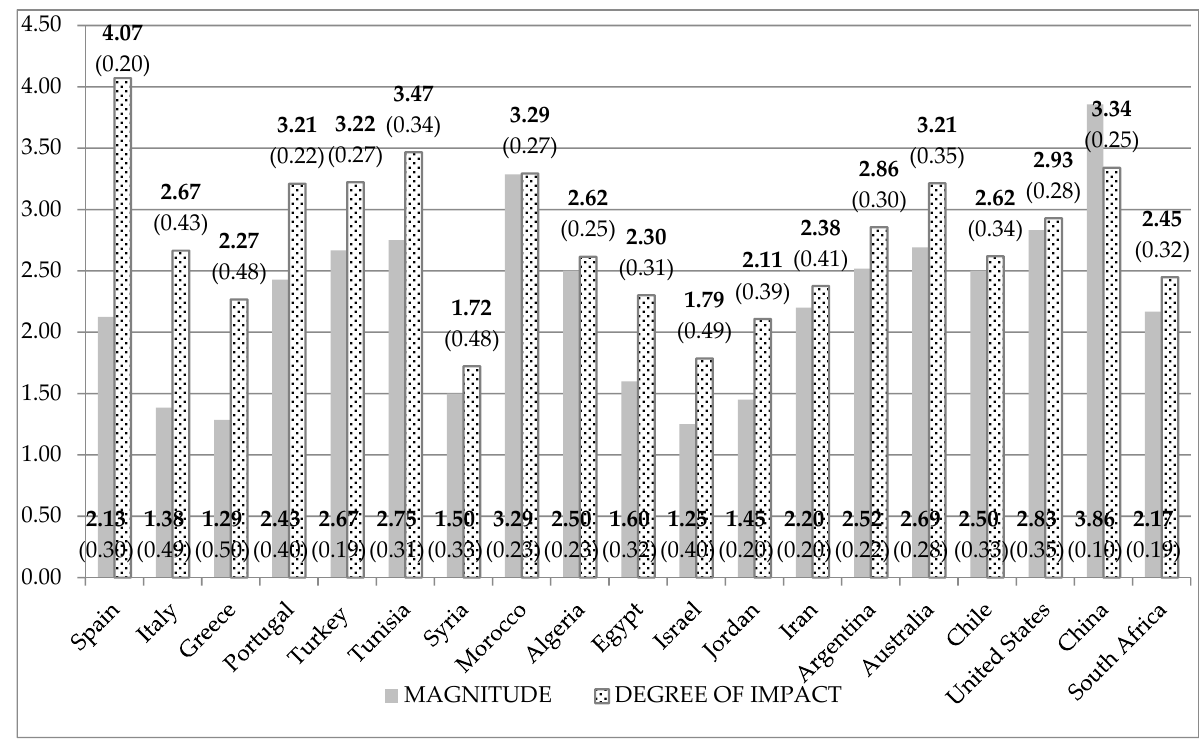
Figure 2. Magnitude of annual increase in world supply of olive oil and its degree of impact on Spanish exports (overall mean and coefficient of variation). Note: Values represent (a) mean annual growth on a four-point scale from “very moderate increase” to “very sharp increase” (figures down in the chart), and (b) mean impact on a five-point scale from “insignificant” to “very significant” (up in the chart). Coefficient of variation values are displayed in parentheses.